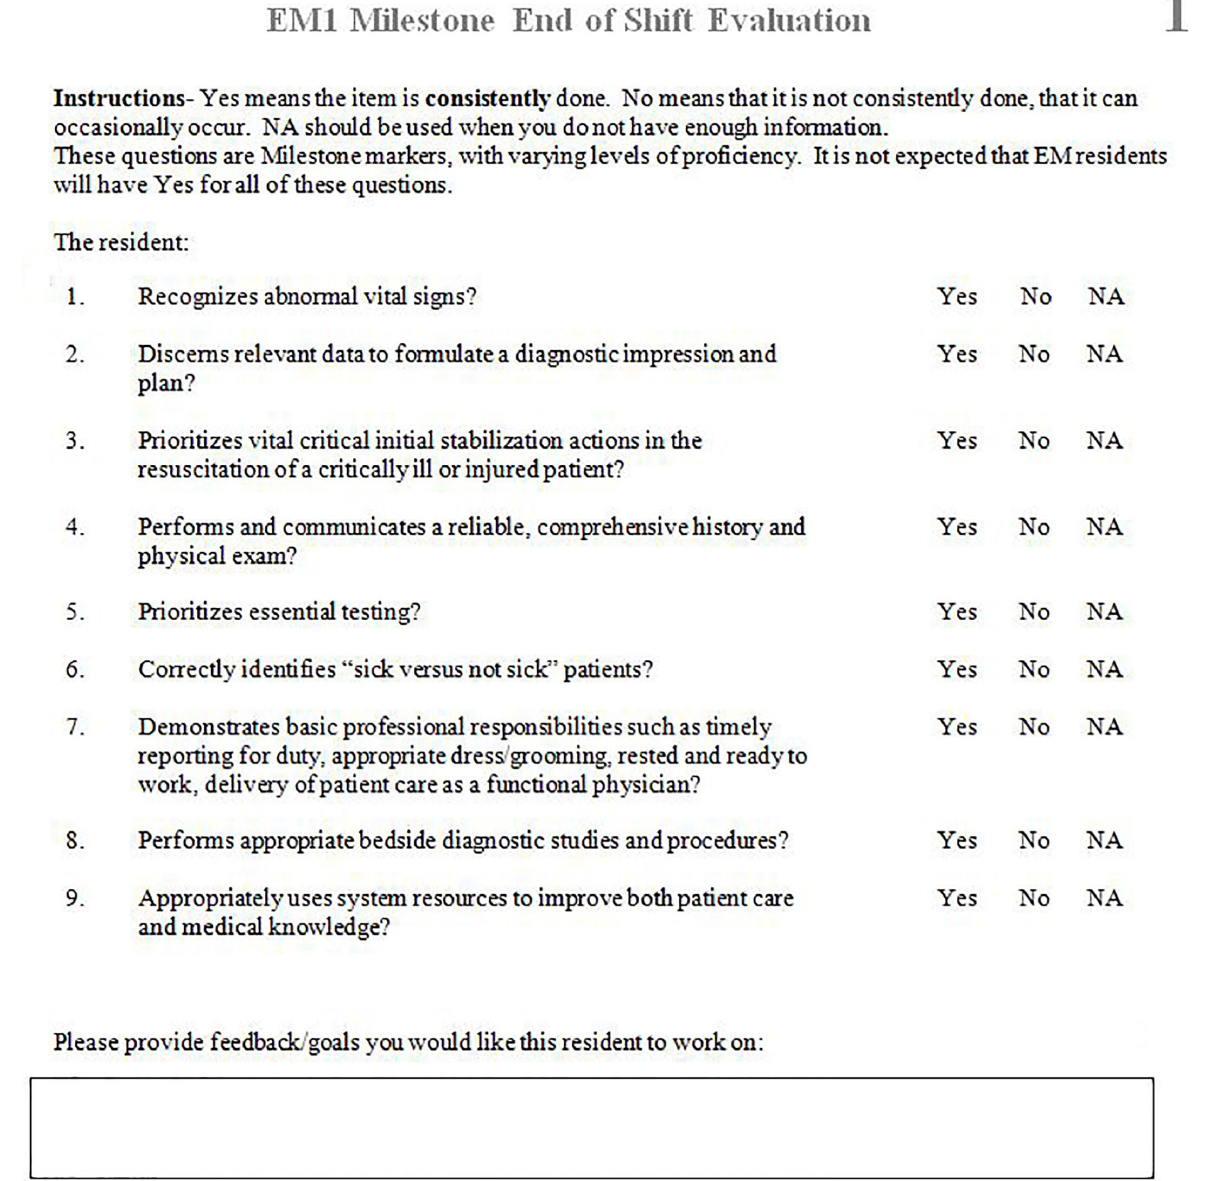
Figure 1. One end-of-shift evaluation form for emergency medicine interns.